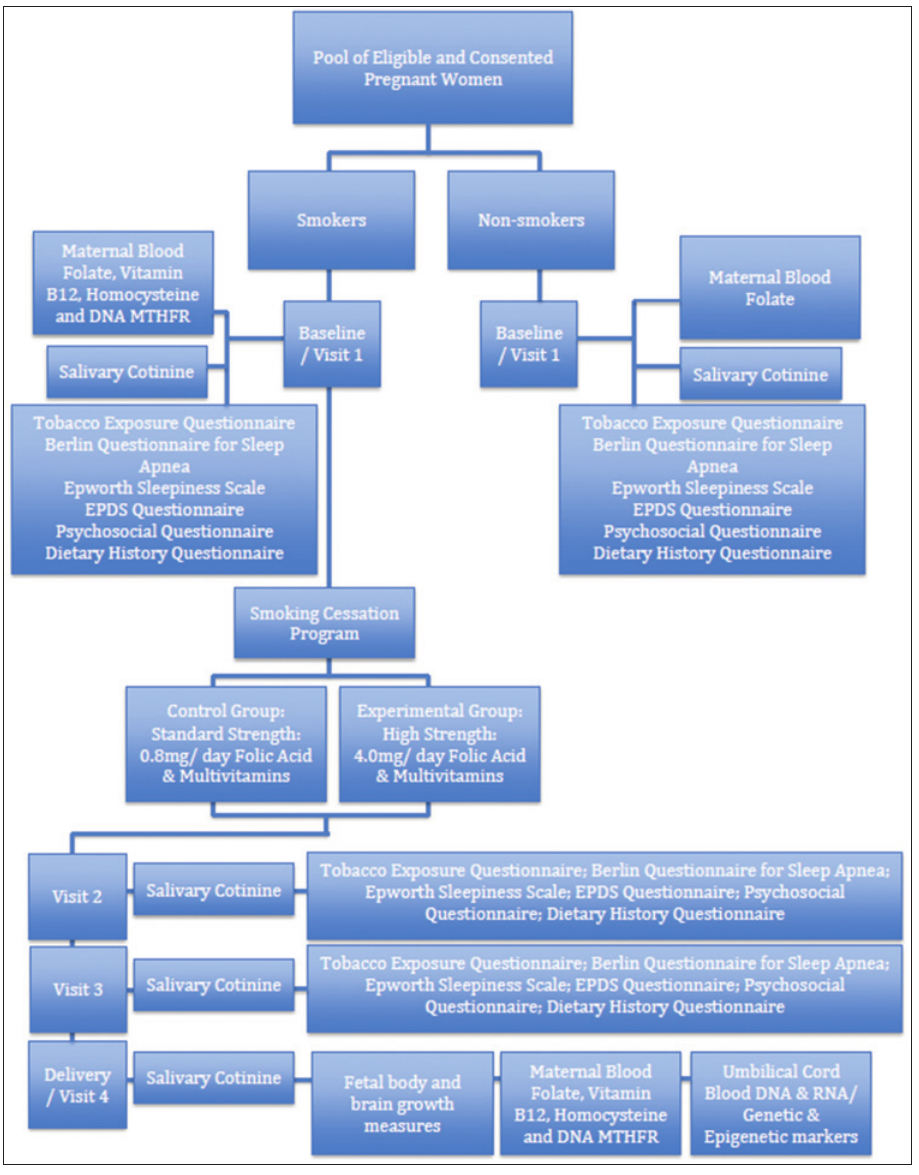
Figure 1. RCT CONSORT Flow